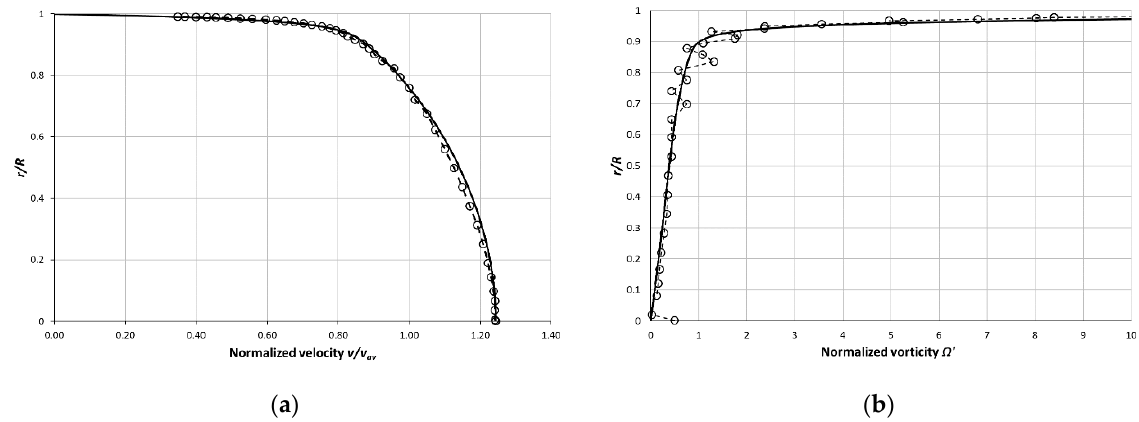
Figure 20. The experimental data (PSP) for Re = 31,577 comparison with predicted mean velocity profile. The empirical formulas for exponents K and N are used only. Dashed line with circles represents the experimental data, the solid line is the analytical profile. ( a ) Normalized mean velocity profile, ( b ) Normalized vorticity distribution.